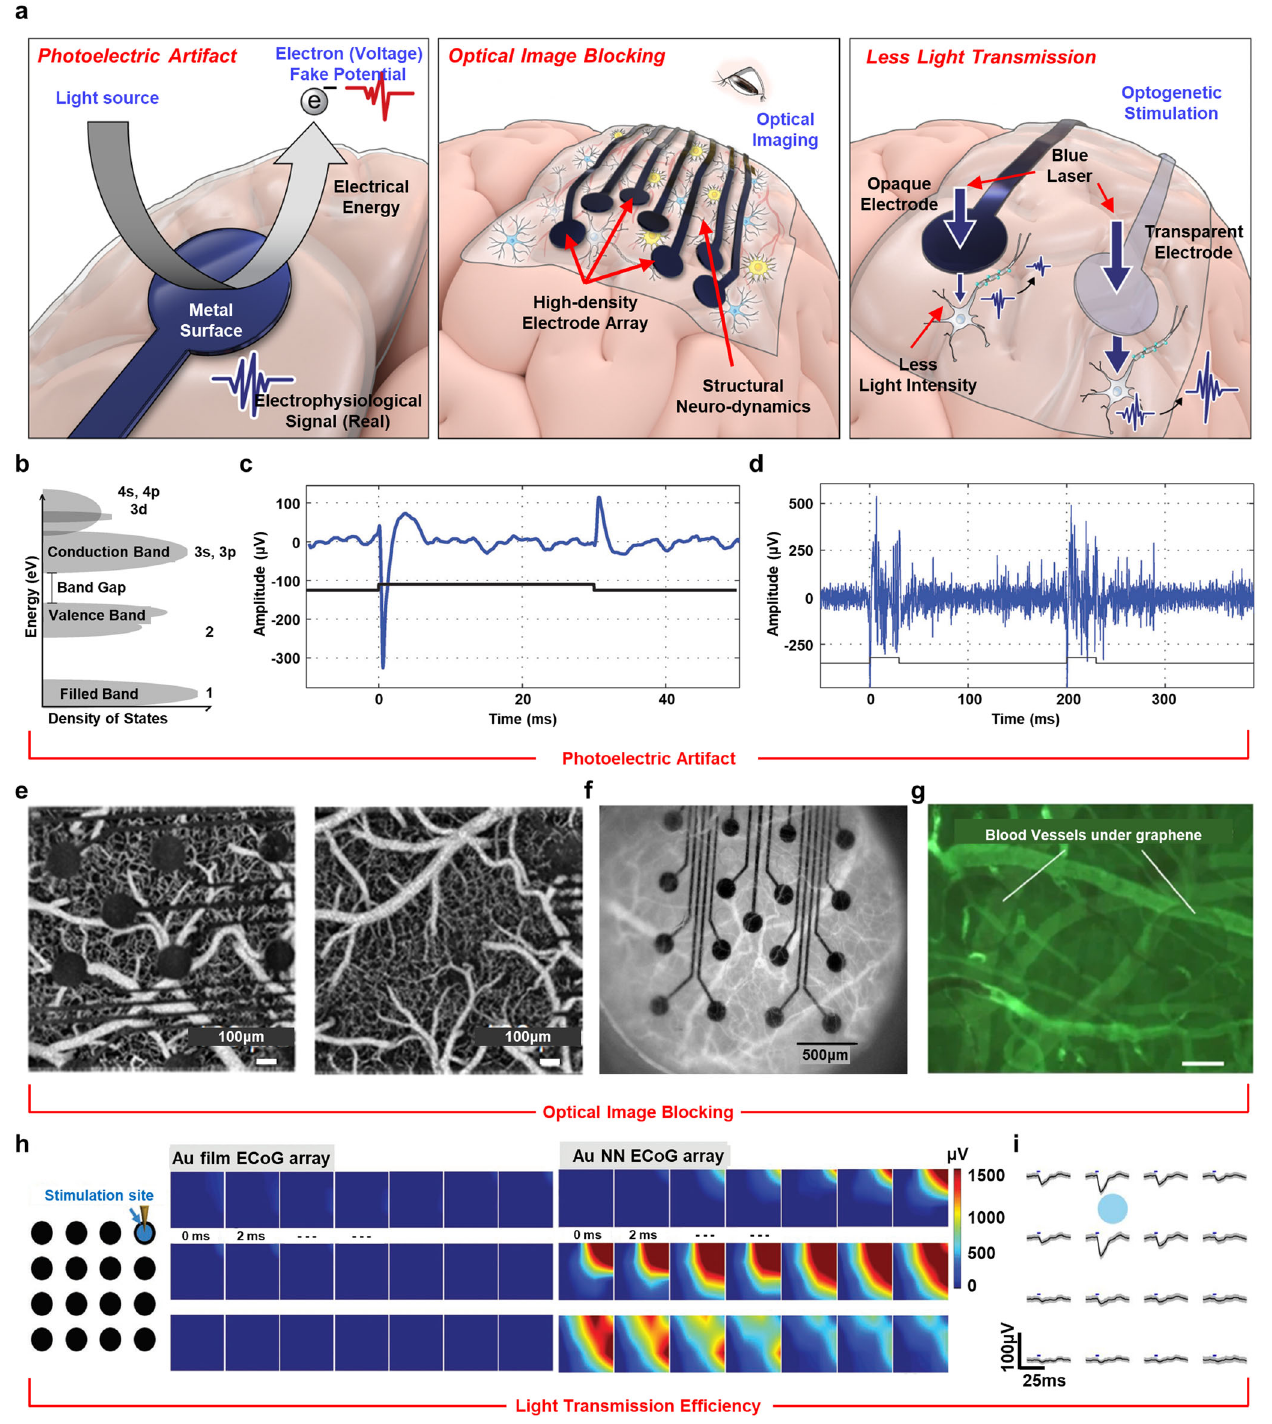
Fig. 3 Challenges with the integration of electrophysiological and optical modalities by non-transparent neural interfaces. a Schematic illustration of challenges from non-transparent electrode array with integration of optical modalities. b Orbital electron energy levels versus the density of each state. c Photoelectric artifact from electrophysiological signals from the brain after 473 nm photo-stimulation with an optical fi ber. d The trace of electrophysiological signals from panel c. The photoelectric artifact is presented as the onset of stimulation. e Optical Coherence Tomography (OCT) imaging of a brain with a non-transparent platinum electrode array (left) and a transparent graphene electrode array (right). f An image of blood vessels from the brain cortex labeled with rhodamine-B dextran through the platinum electrode array from the cranial window. g Fluorescence image of blood vessels with a transparent graphene electrode array. h Spatiotemporal electrophysiological heatmap of a corresponding electrode channel upon illumination of the 473 nm laser directly on the surface of the Au fi lm electrode (left), and an Au nanonetwork electrode (right). i Spatially distributed electrophysiological potentials from the optogenetic stimulation. The blue color represents the illumination spot. Panels b, c, and d reprinted with permissions from ref. 19 , Royal Society of Chemistry. Panels e and g reprinted with permissions from ref. 16 , Springer Nature. Panels f and i reprinted with permissions from ref. 90 , IOP publishing. Panel h reprinted with permissions from ref. 18 ,